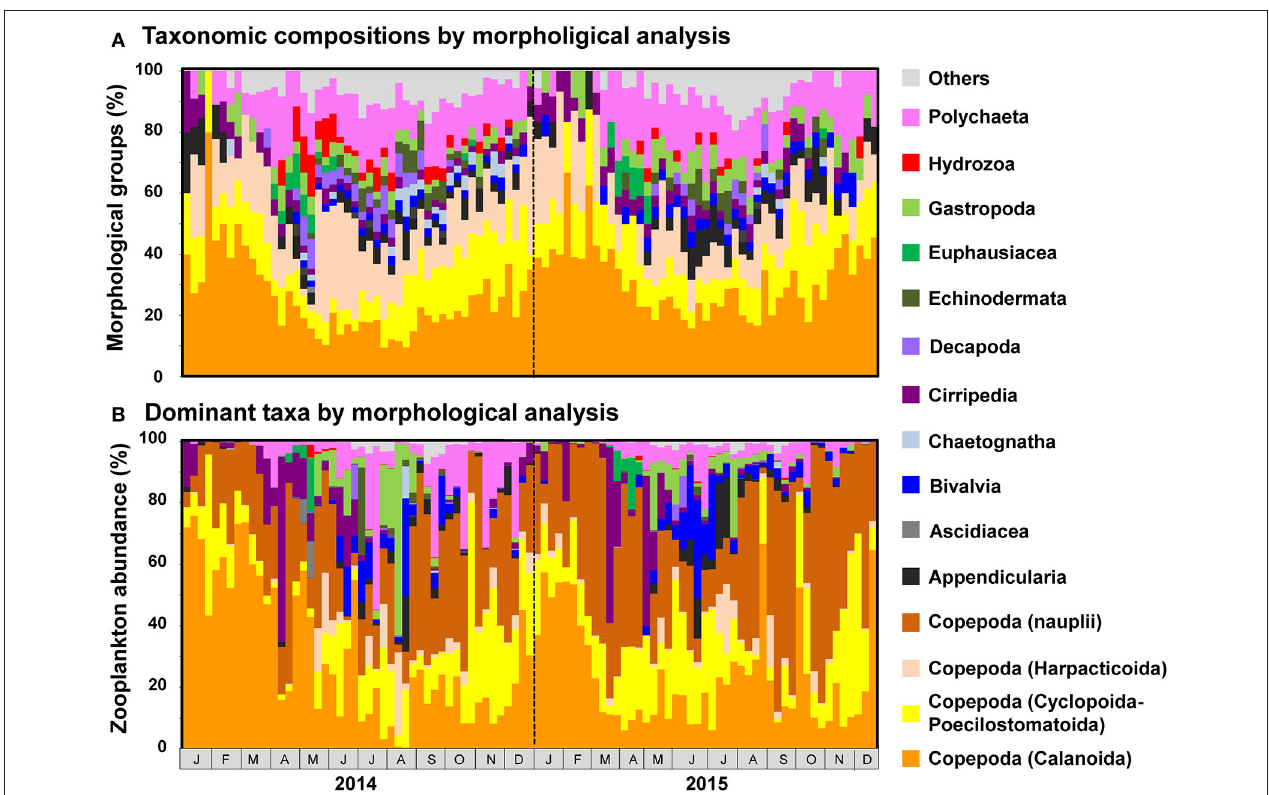
FIGURE 6 | Seasonal changes in (A) taxonomic composition and (B) abundance of major morphological groups, as detected by morphological analysis. Individuals attributable to Copepoda are classified to order. Taxonomic groups that did not contribute to ≥ 10% of all sequences in any sample are grouped under